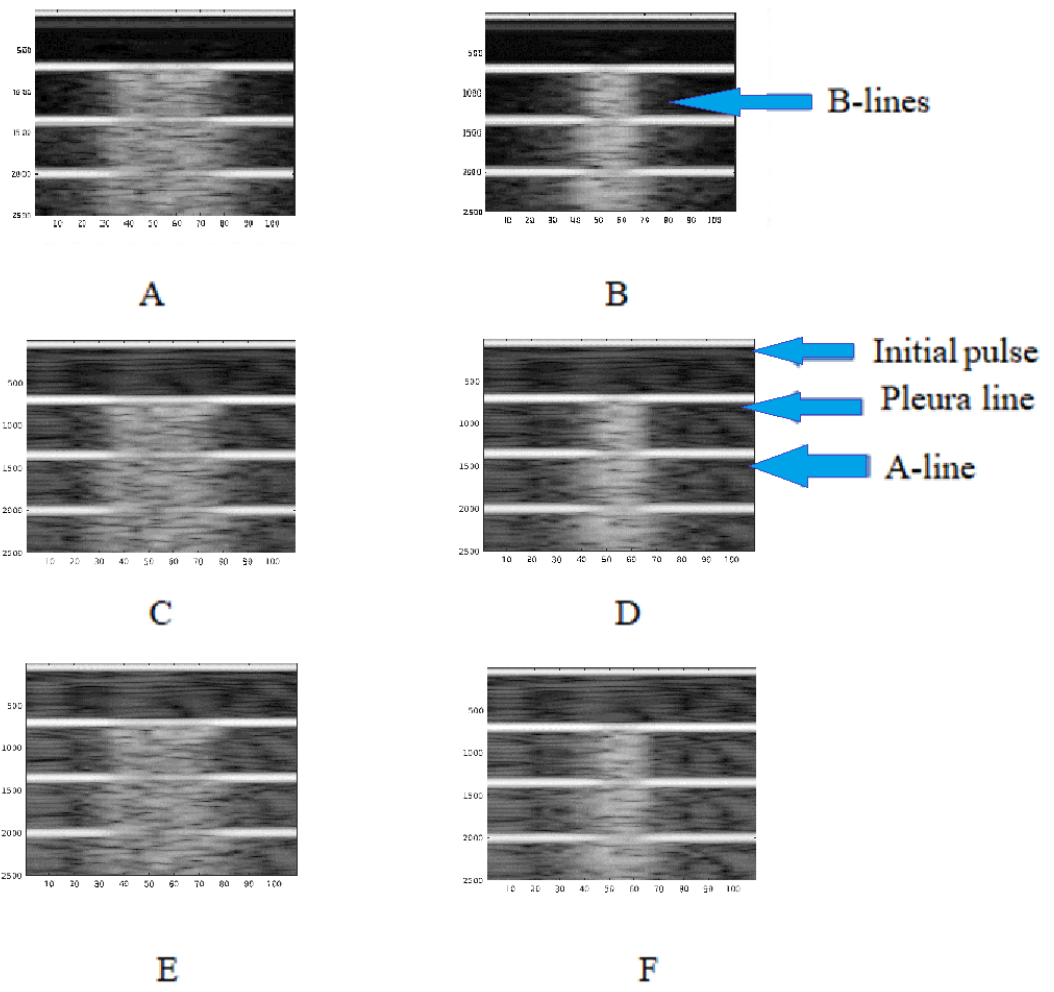
Figure 9. Imaging obtained at different G level and domains. For ( A ) and ( B ), G = 0; ( C ) and ( D ), G = 5; ( E ) and ( F ), G = 10. The left column corresponds to domain A, in Figure 4. The right column corresponds to Domain B in the same figure. The A-lines (horizontal) vs. B-lines (vertical) are shown in B and D, as examples.